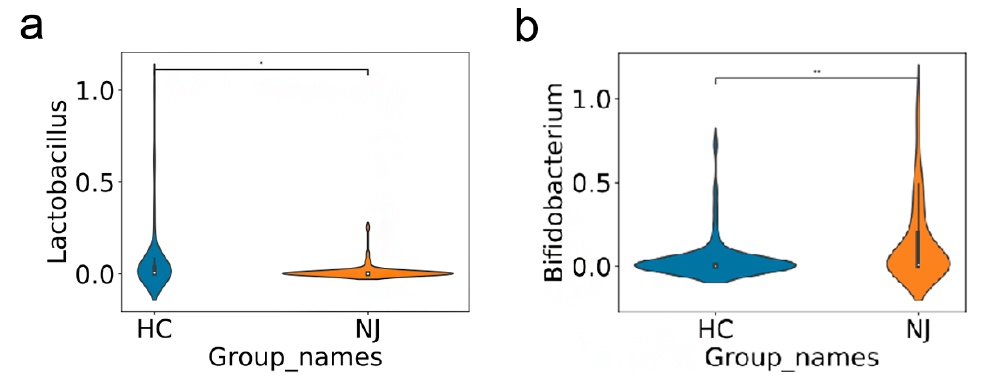
Figure 4. The composition ratios of bifidobacteria and lactobacilli varied between the groups. The same color is used for the same group of samples; blue represents healthy controls; yellow represents neonatal jaundice. ( a ) Bacterial compositions differed in the stool samples of both groups; the vertical coordinate represents the bacterial composition ratio; larger values indicated higher proportions in the group where the organism was located. ( b ) Numbers of species detected in the stools of the neonatal jaundice group and the healthy controls; the bifidobacterial distribution was higher in the neonatal jaundice group; the Lactobacillus distribution was significantly lower. Bifidobacterium was the dominant microorganism in the feces of jaundiced neonates, and the Lactobacillus content was significantly lower than that in the control group.*, P value < 0.5,**, P value < 0.01.